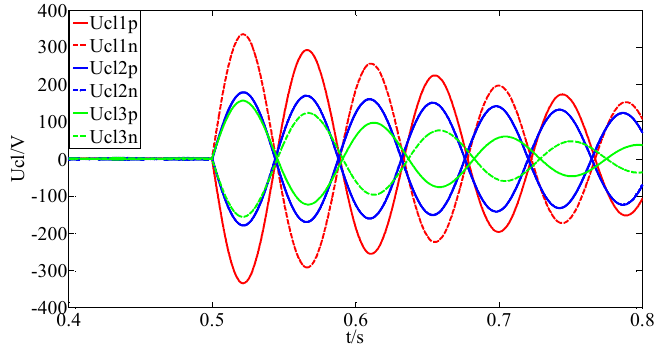
Figure 12. Voltage waveforms of the CLIs during the AC three-phase fault